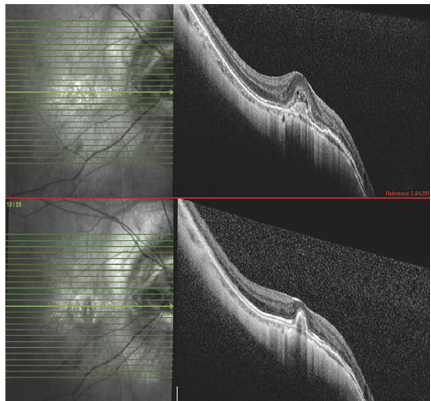
Figure 4: In one demonstrative case of the IVR group, the re- gression of the subretinal fluid after two consecutive monthly IVR administrations is clearly seen in a comparison of foveal